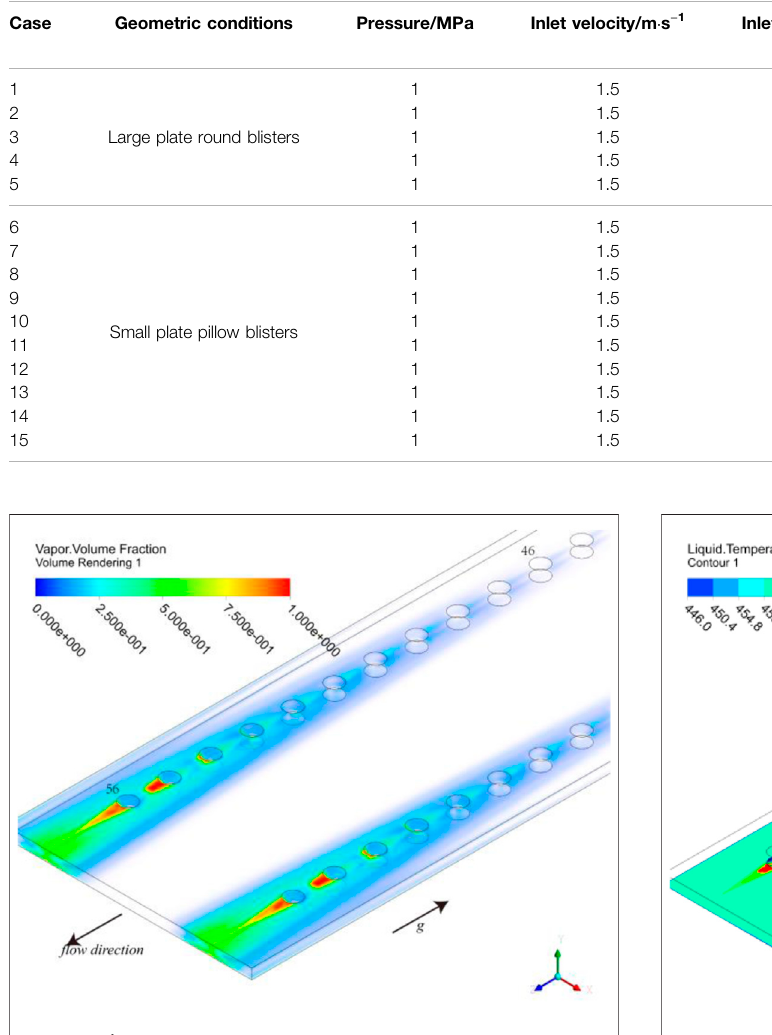
FIGURE 5 | Void fraction distribution of channels for case5.